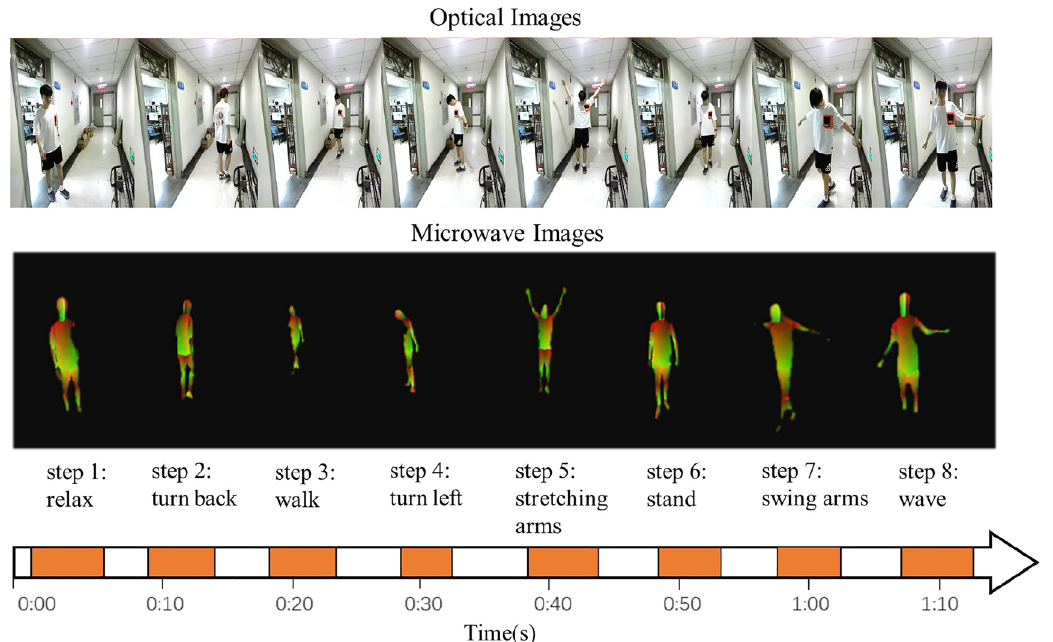
Figure6: Experimental in-situ imagingresultsofthetestpersonfreelyactinginacorridoroutsideourlabwitha60cm-thicknessload-bearing concretewall.( Top )RGBimagesrecordedbyopticalZED2cameraatselectedmoments.( Middle )IUVimagesbyourintelligentEMmetasurface camera at selected moments corresponding to that in top row. ( Bottom ) Time